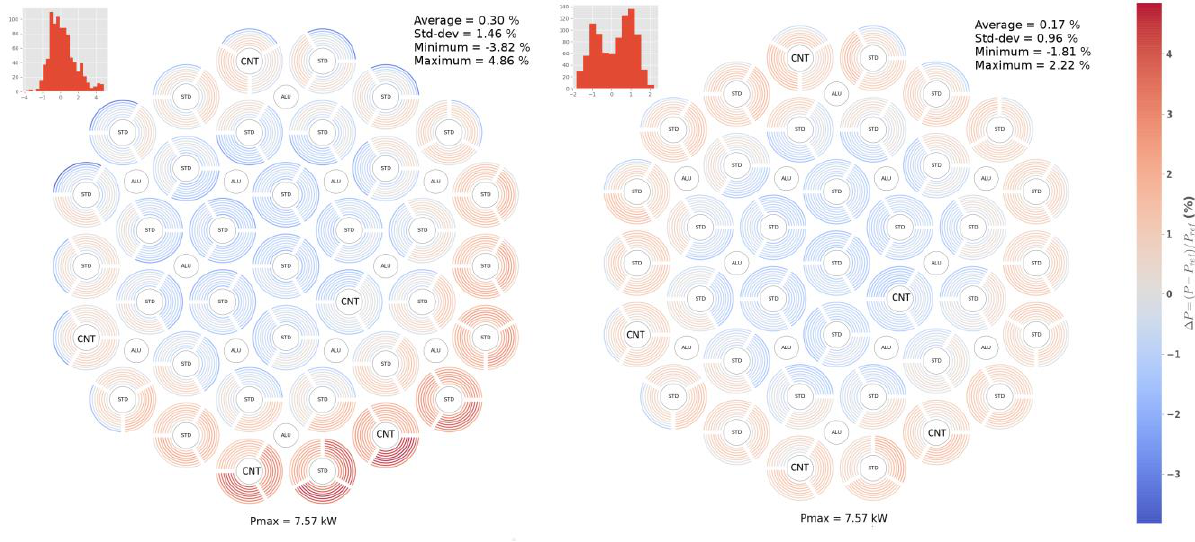
Figure 6. Results on fission rates per assemblies for the former (left)/ new (right)